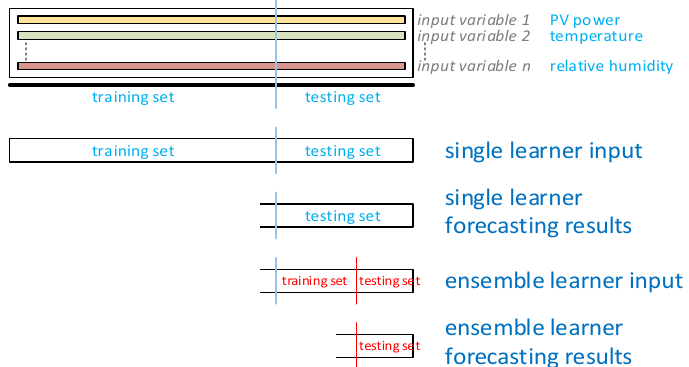
Figure 8. Data preparation. Figure 7. The detailed process of the proposed ensemble forecasting